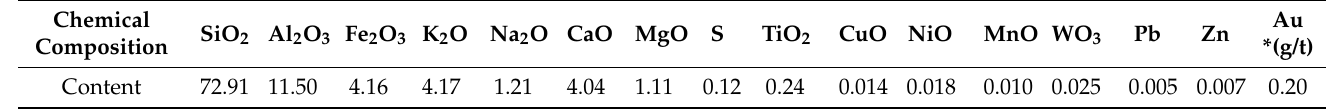
Table 1. Chemical composition of tailings samples from quartz vein-hosted gold deposits (mass fraction, %).